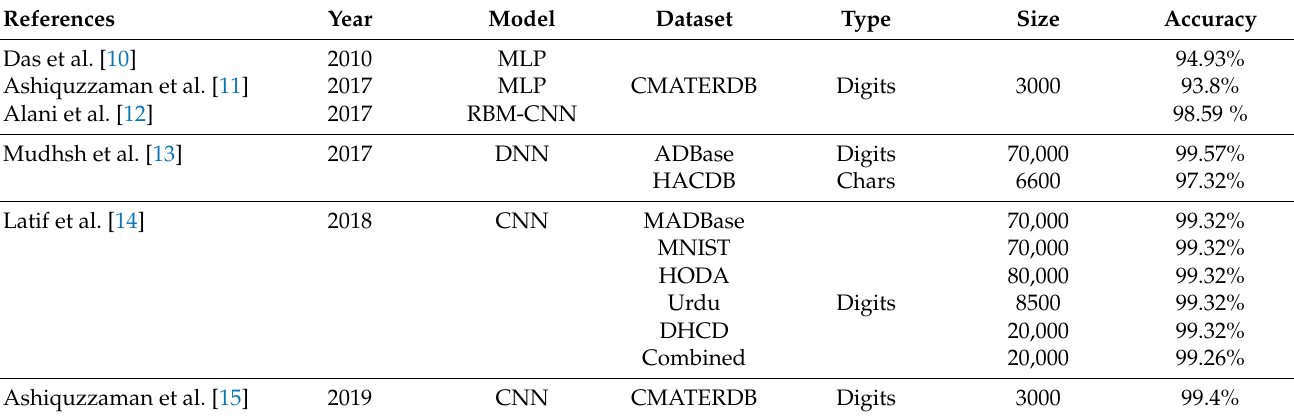
Table 1. A summary of deep learning-based handwritten digit recognition